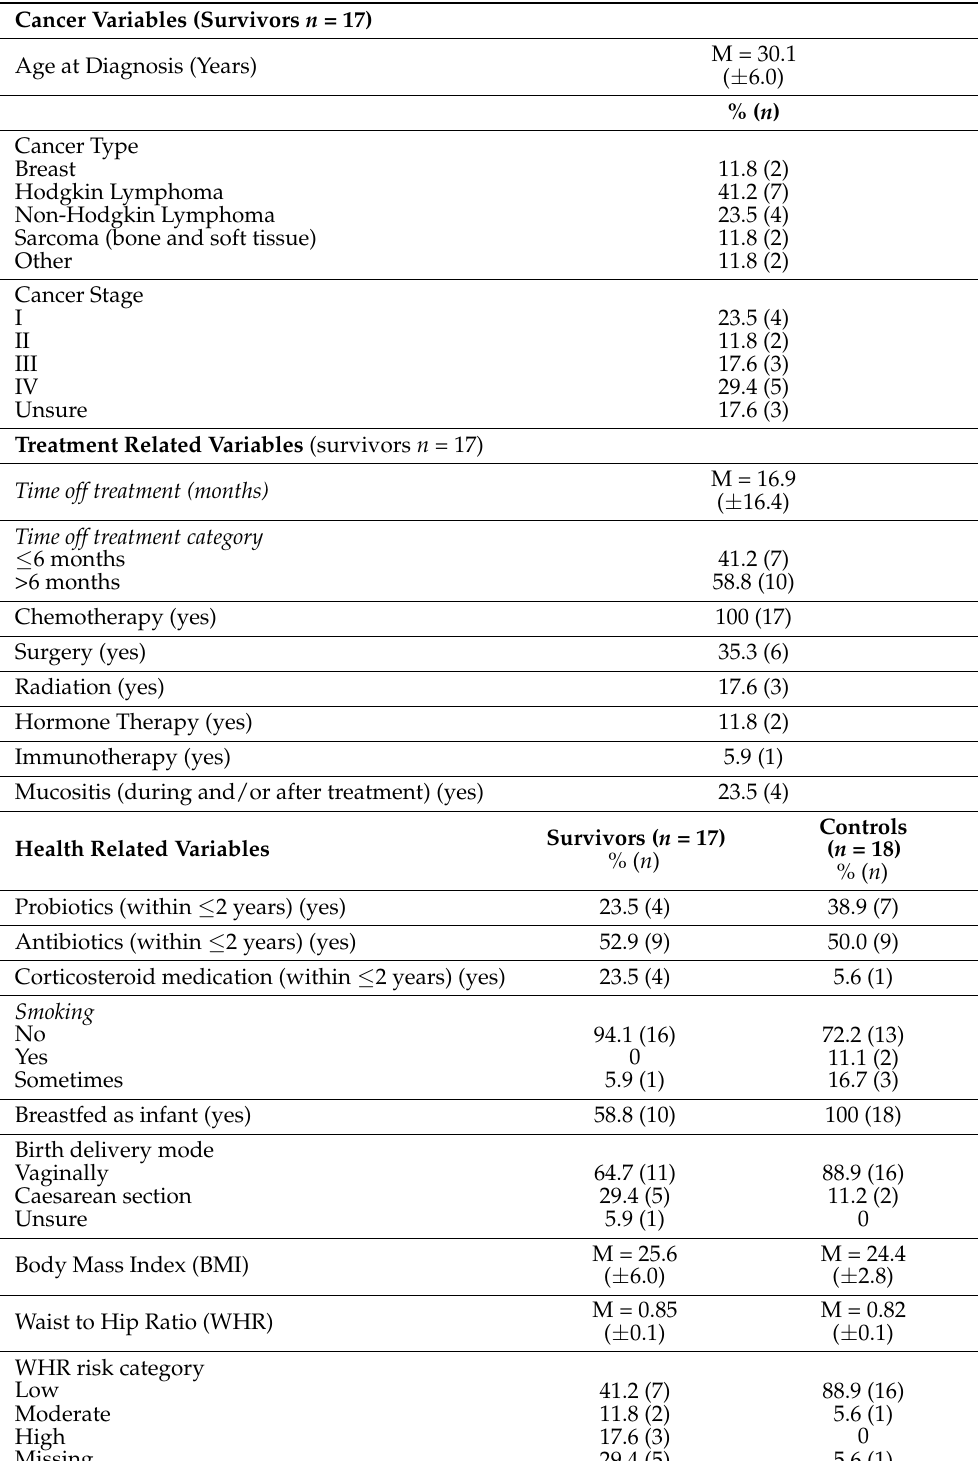
Table 2. Clinical and treatment-related characteristics of survivors and